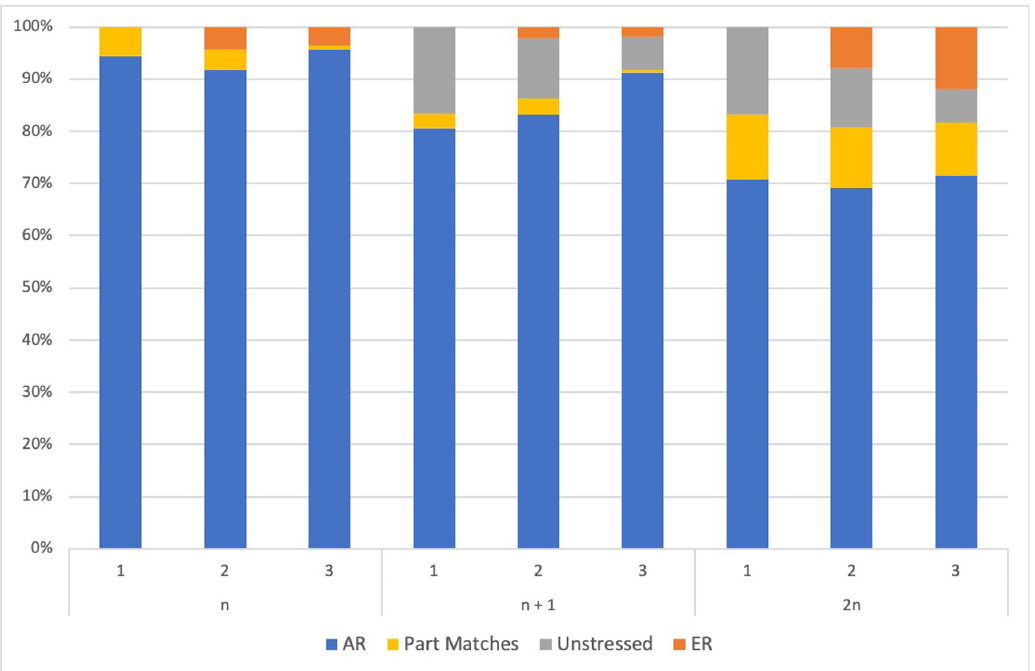
Figure 11: Distribution of aligned word tokens as a function of stress